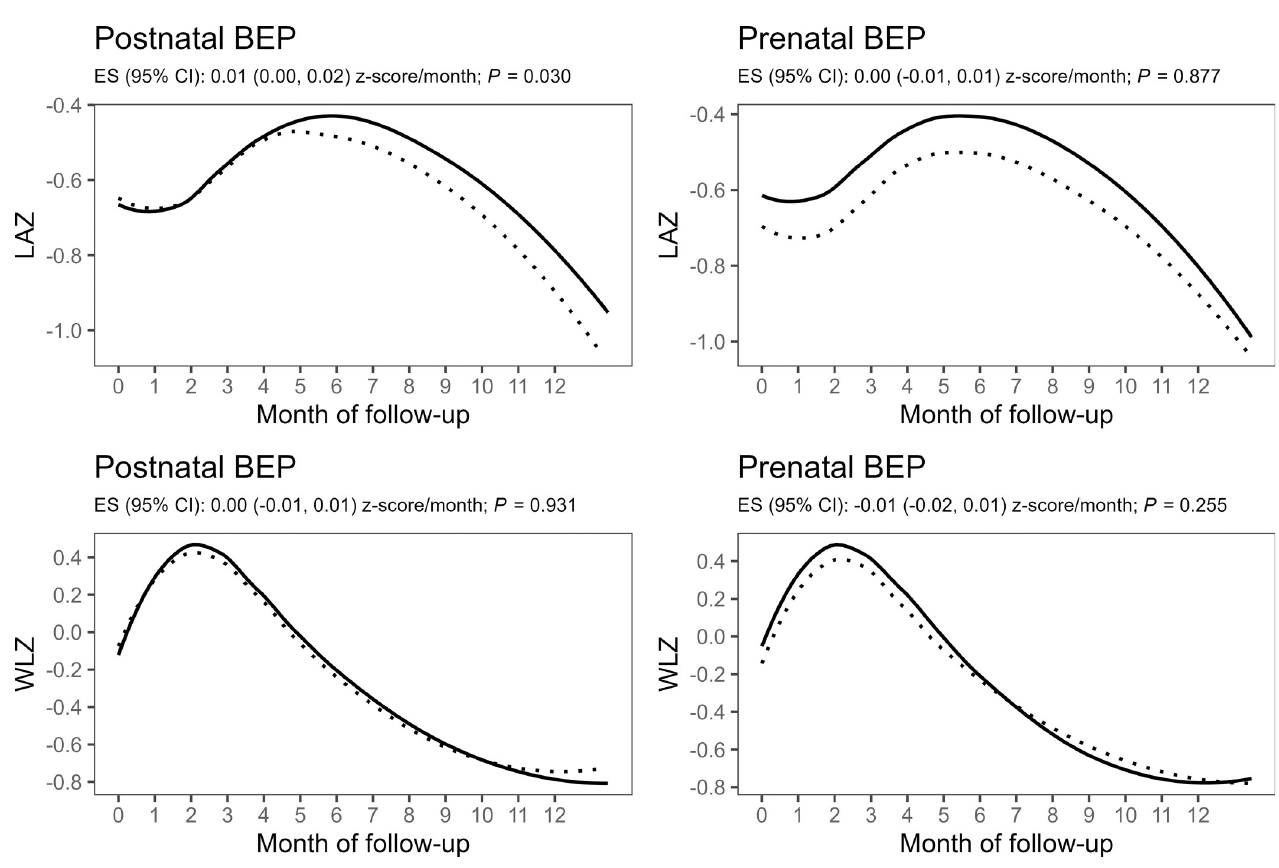
Fig 2. Monthly changes in LAZ (upper panels) and WLZ (lower panels) by postnatal (left panels) and prenatal (right panels) intervention arms with the dashed lines representing the control group (IFA) and solid lines representing the intervention group (IFA + BEP). Line graphs represent locally weighted scatterplot smoothing of observed values. Group differences were estimated using mixed-effects models with random intercepts for infant and random slopes for intervention time, with fixed effects including time, quadratic time (for LAZ), intervention group, and time × group interaction adjusted for allocation to the other intervention, clustering indicators (health center and randomization block), and a priori determined prognostic factors (maternal height, BMI, MUAC, hemoglobin, age and gestational age at inclusion, and parity). BEP, balanced energy–protein supplement; BMI, body mass index; CI, confidence interval; ES, regression coefficient; IFA, iron–folic acid; LAZ, length-for-age Z-score; MUAC, mid-upper arm circumference; WLZ, weight-for-length